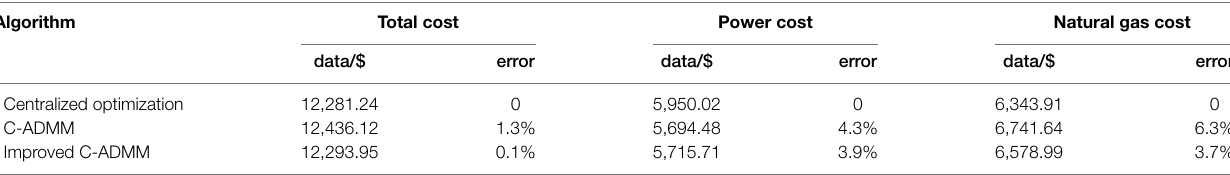
TABLE 3 | Comparison of the algorithm